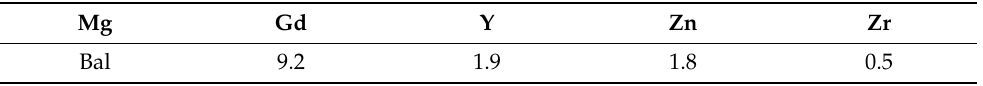
Table 1. Chemical composition (wt%) of a Mg–9Gd–2Y–2Zn–0.5Zr